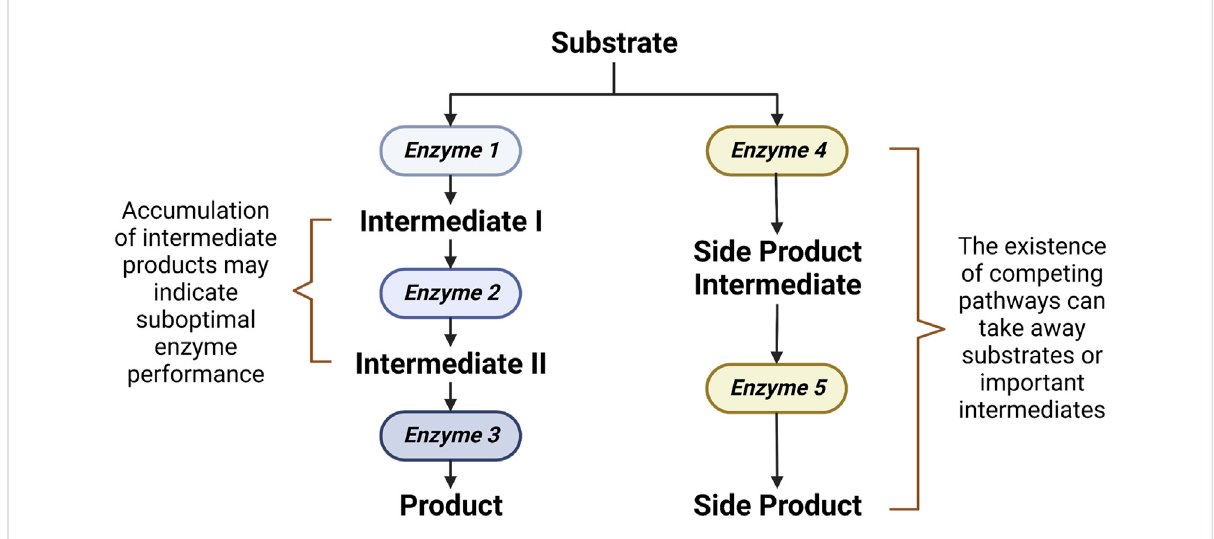
FIGURE 2 Rate-limiting steps in a synthetic biological